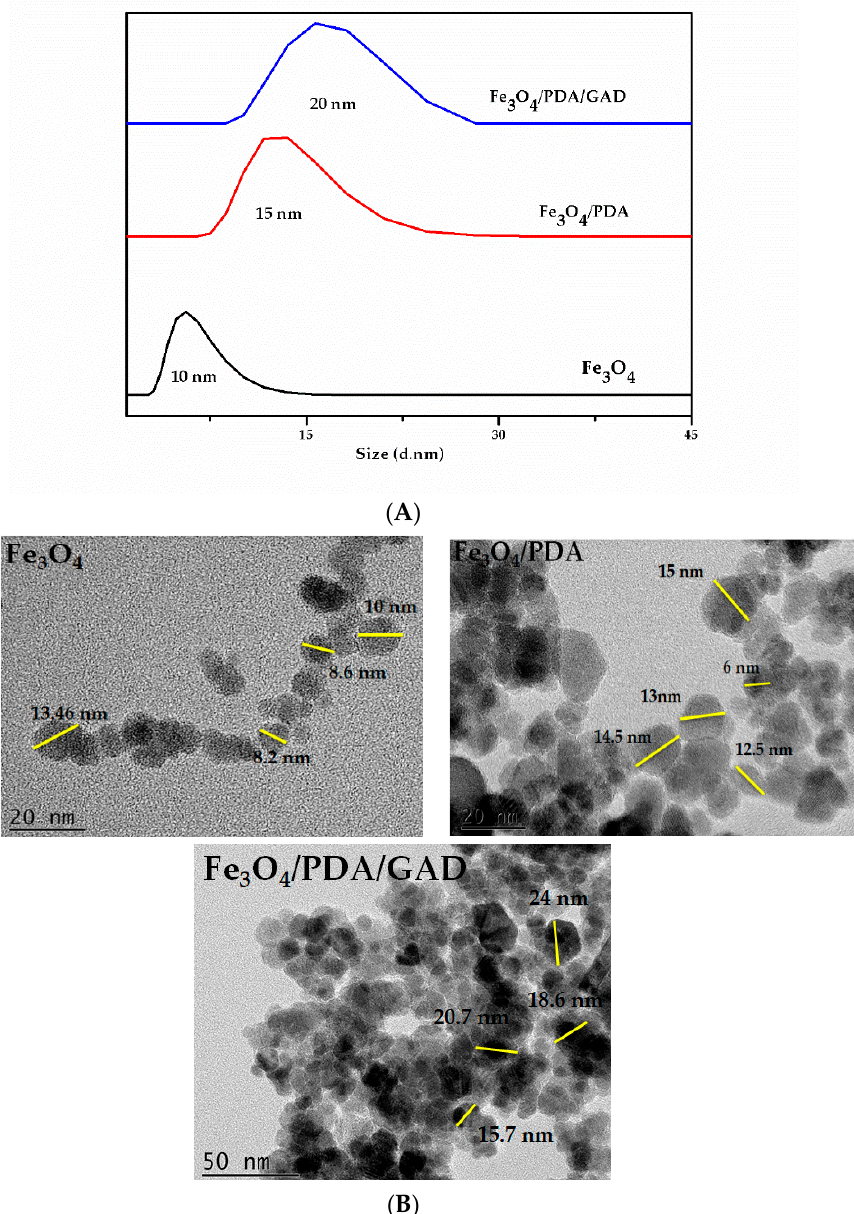
Figure 5. ( A ) Nanoparticle size distribution as measured by DLS for Fe 3 O 4 , Fe 3 O 4 /PDA,